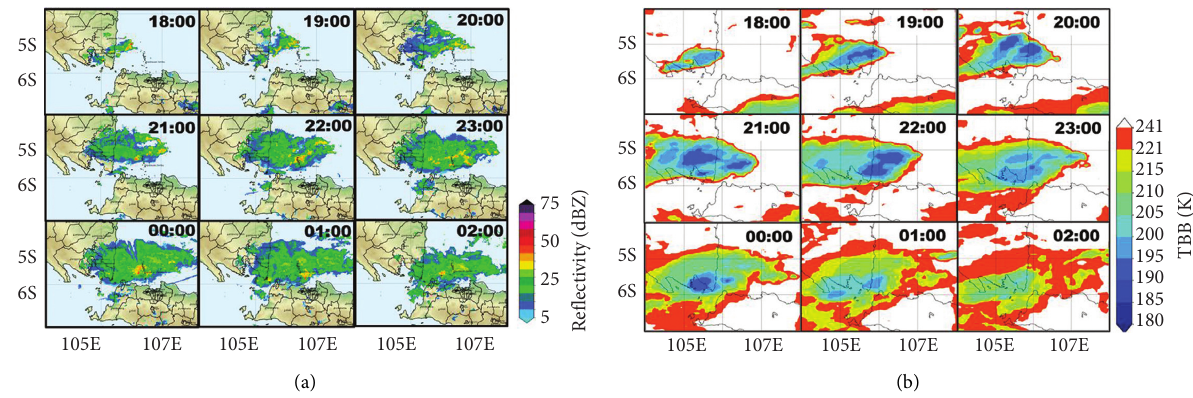
Figure 5: Hourly evolution of January 1-2, 2021, from 18:00 to 02:00 LST for (a) rainfall observed by BMKG radar and (b) mesoscale convective complex from Himawari satellite. The colour gradation from yellow to blue indicates interior cold cloud with TBB ≤ 221K and brown colour indicates cloud shield with 221K ≤ TBB ≤